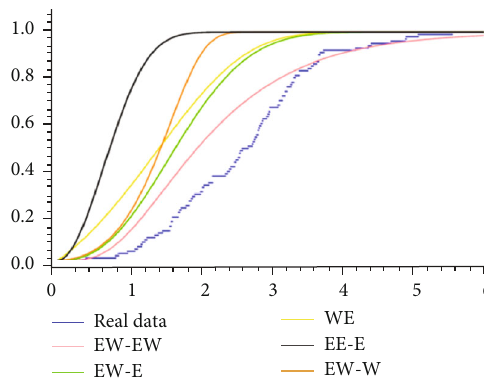
Figure 5: Plot CDF of the EW-EW, EW-E, WE, EE-E, and EW- EW with the empirical distribution for the 2 nd data.